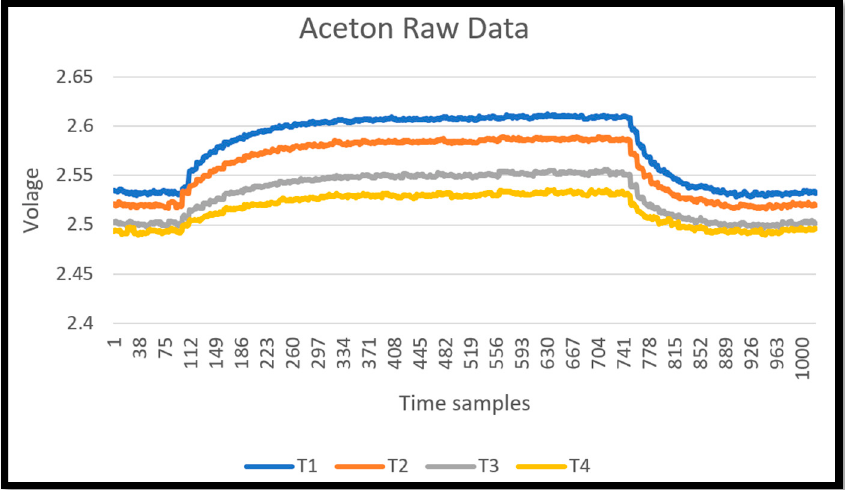
Figure 3. A GMOS reaction in the presence of 100 PPM Acetone, sampled.